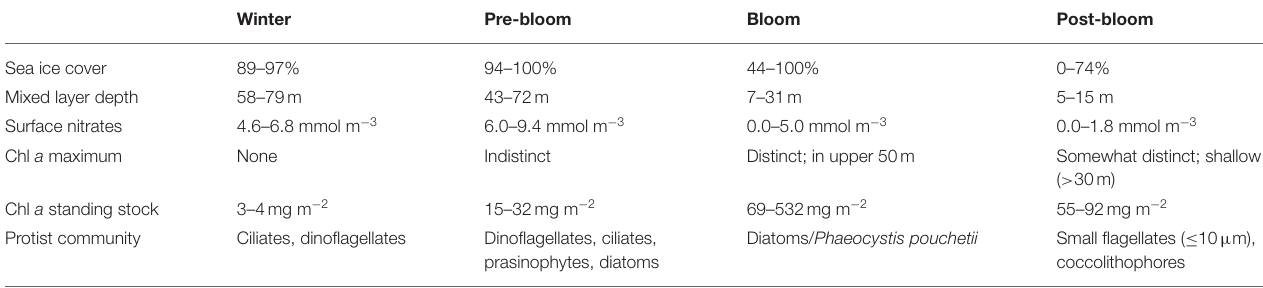
TABLE 2 | Conditions for bloom stage categorization.